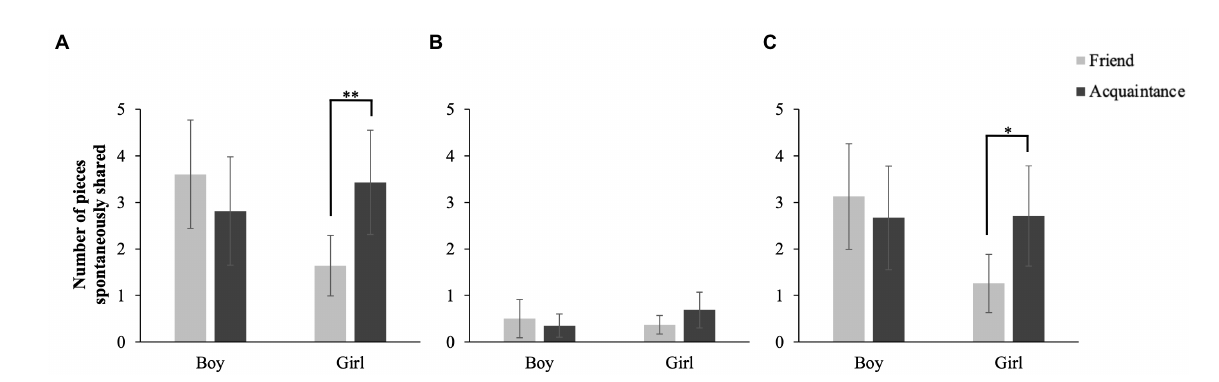
η p2 = 0.085 (medium effect). Girls spontaneously shared more food with acquaintances than with friends, t (42) = − 3.16, p = 0.003, d = 0.60 (Figure 2A). For boys, patterns of spontaneous sharing did not differ between friends and acquaintances, t (47) = 1.26, p = 0.205, d = 0.20. No other effects were significant ( p -values ranged from 0.087 to 0.988).